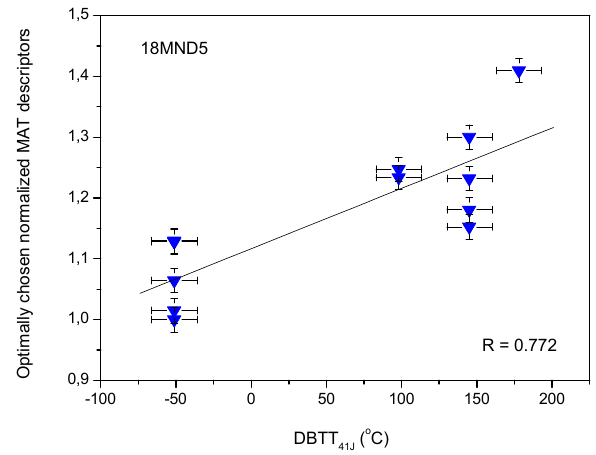
Figure 7. Optimally chosen MAT descriptor of reference and of irradiated 18MND type weld material as a function of transition temperature, DBTT.